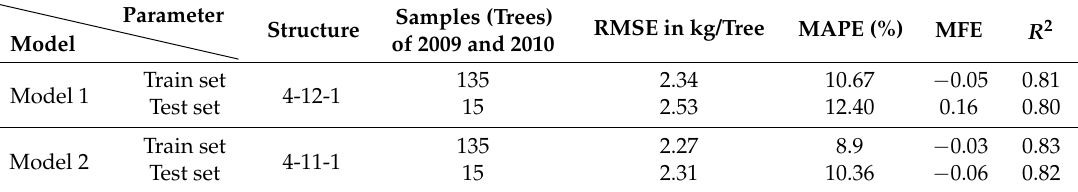
Table 5. The model structure and the evaluation of model performance for cv. “Gala”.